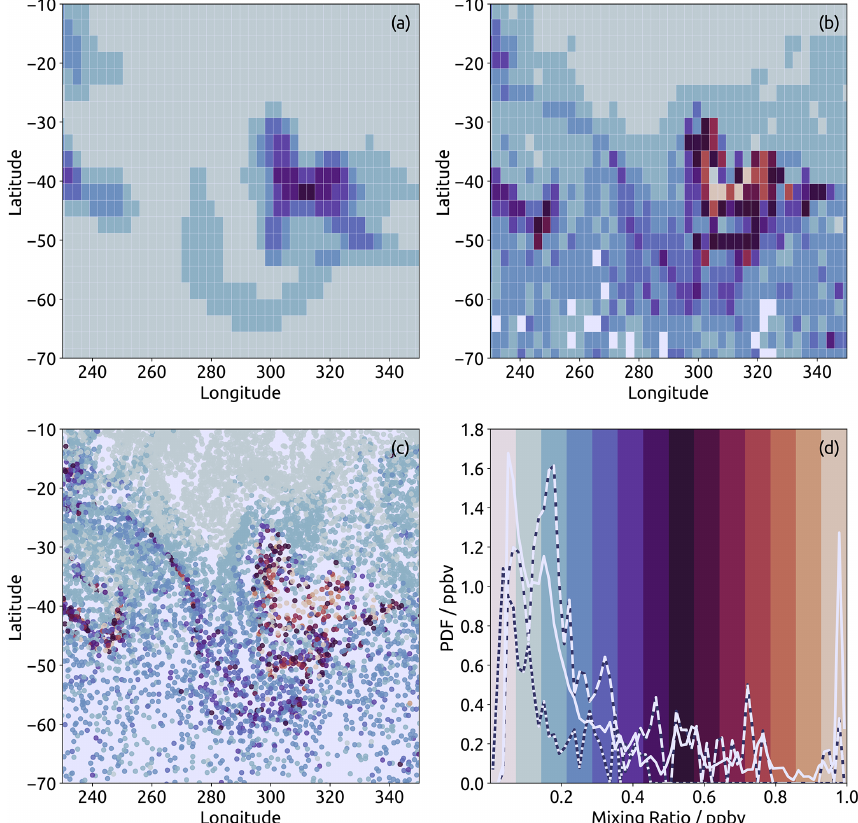
Figure 11. Region from the plume injection experiment showing results for a long-lived (365d lifetime) tracer. (a) EMAC-FFSL results on the EMAC grid at model level 63 (approximately 100hPa, and the level at which plume injection occurred). (b) EMAC-CLaMS results gridded onto the EMAC model grid at the same level as the EMAC results. (c) EMAC-CLaMS data for parcels within EMAC model level 63 in the unprocessed Lagrangian representation. (d) Histograms showing distributions of tracer mixing ratios within the shown region. The color map used in (a–c) corresponds to the background colors in (d) . Histograms are shown for unprocessed EMAC-CLaMS results (solid line, corresponding to distribution in c ), EMAC-CLaMS gridded results (long-dashed line, corresponding to distribution in b ), and EMAC- FFSL results (short-dashed line, corresponding to distribution in a ). Histograms are computed using only data which are shown in the other three panels (i.e., within the shown region and within EMAC model level 63), and the histograms of gridded results are